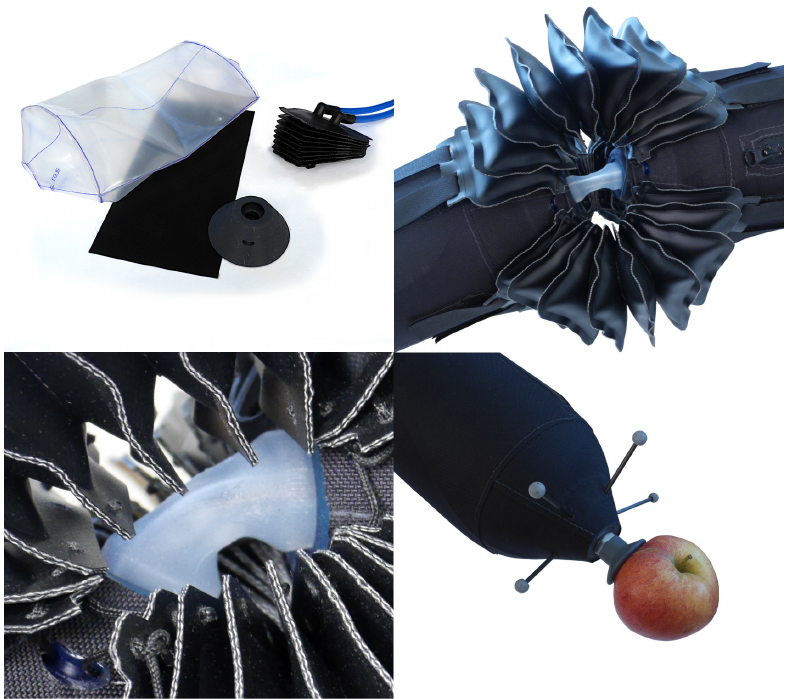
Figure 4. ( Top left ) The inner bladder of the movable link, the fabric for the outer shell, a support cone with the recess in the middle into which the soft joint fits, and an actuator with the tubing connected. ( Top right ) The actuators arranged around the soft joint (white cylindrical part) and connected to both links. ( Bottom left ) The deformed soft joint when the movable link is deflected. The actuators are attached to the support cones with strings. ( Bottom right ) The tip of the movable link allows us to attach different suction cups to grasp different objects, such as an apple. Markers for the motion capture system are attached for sensory feedback. The markers and the suction cup are mounted to the support cone that is glued to the interior side of the movable link